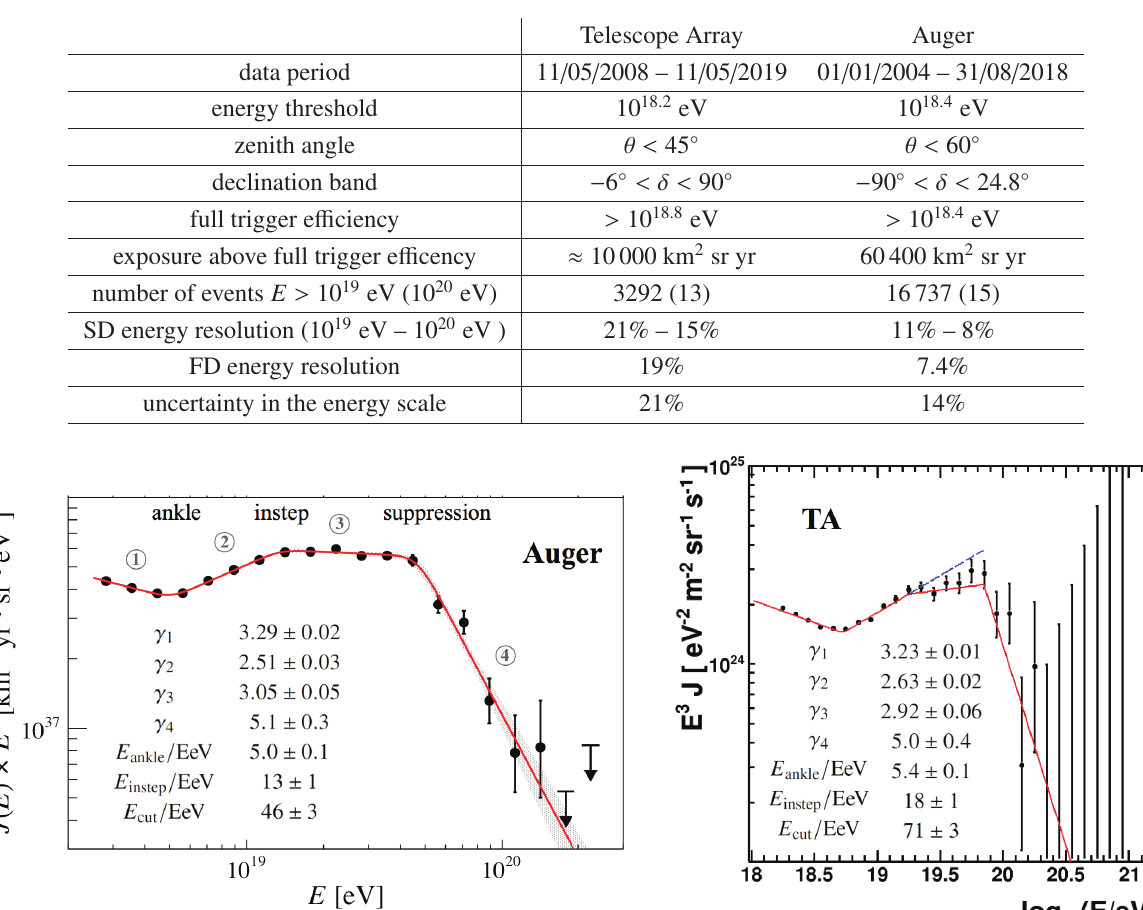
Table 2. Parameters relevant for the measurements of the energy spectrum at the Auger Observatory [7] and the Telescope Array [9].